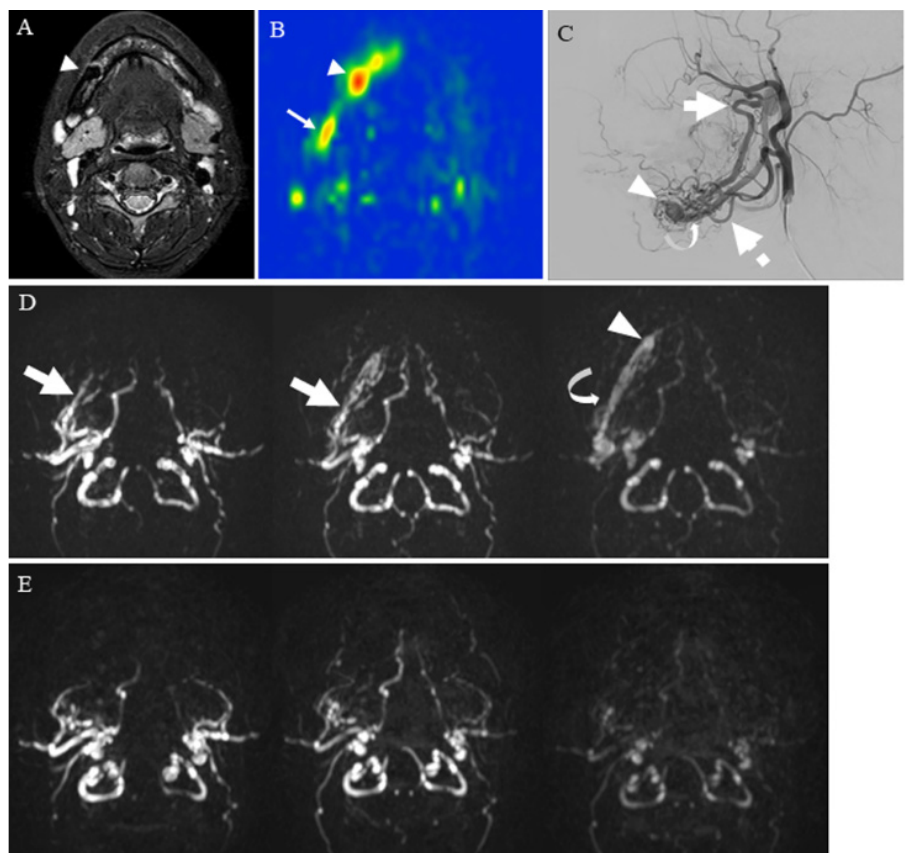
Figure 7. A 24-year-old female with mandibular arteriovenous malformation (AVM): ( A ) STIR shows an intraosseous flow void of the jaw (arrowhead), suggestive of AVM nidus; ( B ) pCASL image shows markedly elevated blood flow of the nidus (arrowhead) (mean of 374.83 mL/100 g/min) and high blood flow surrounding the nidus (arrow); ( C ) right external carotid angiography reveals that the AVM is predominantly supplied by the right inferior alveolar artery (thick arrow) and mental artery (dashed arrow) with drainage into the right inferior alveolar vein (curved arrow) via the nidus (arrowhead); ( D ) contrast inherent inflow-enhanced multiphase angiography (CINEMA) shows that the AVM is supplied by the right inferior alveolar artery (thick arrows) and drained into the right inferior alveolar vein (curved arrow) via the nidus (arrowhead) before treatment; ( E ) after the right alveolar artery and vein embolization, no feeder, drainage vein, or nidus is depicted.